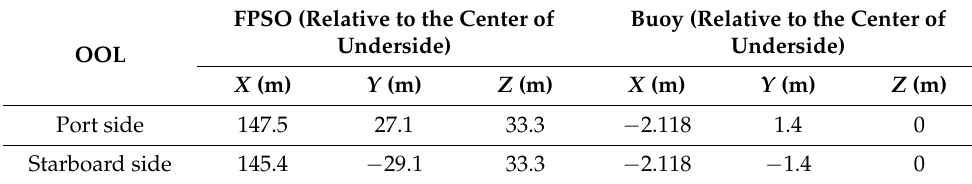
Figure 4. Numerical model of the buoy and the corresponding mooring lines and OOLs. Table 2. Coordinates of the OOL connecting points on FPSO and buoy.